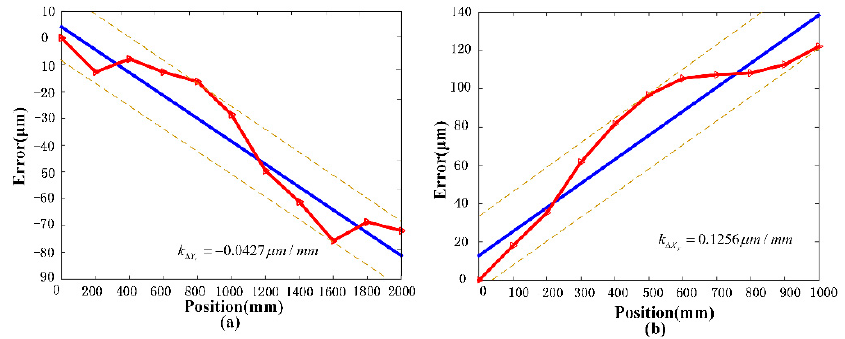
Figure 11. Straightness error curves of ∆ Y x and ∆ X y . ( a ) Straightness errors ∆ Y x curves; ( b ) straightness errors ∆ X y curves.